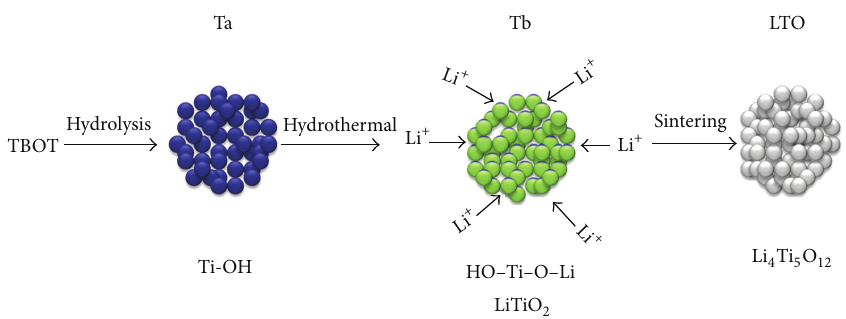
Figure 6: Illustration of the possible formation process of Li 4 Ti 5 O 12